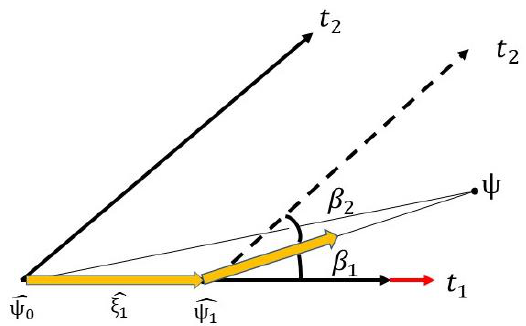
Figure 3. Pictorial illustration of the least angle regression.